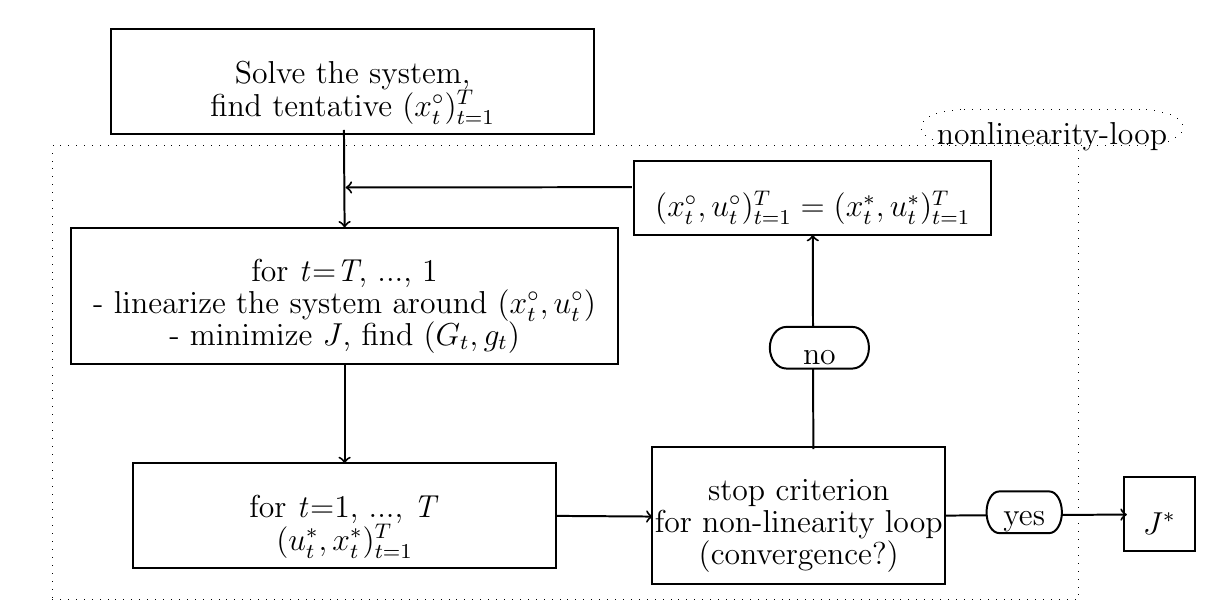
Figure 1. Flow chart of